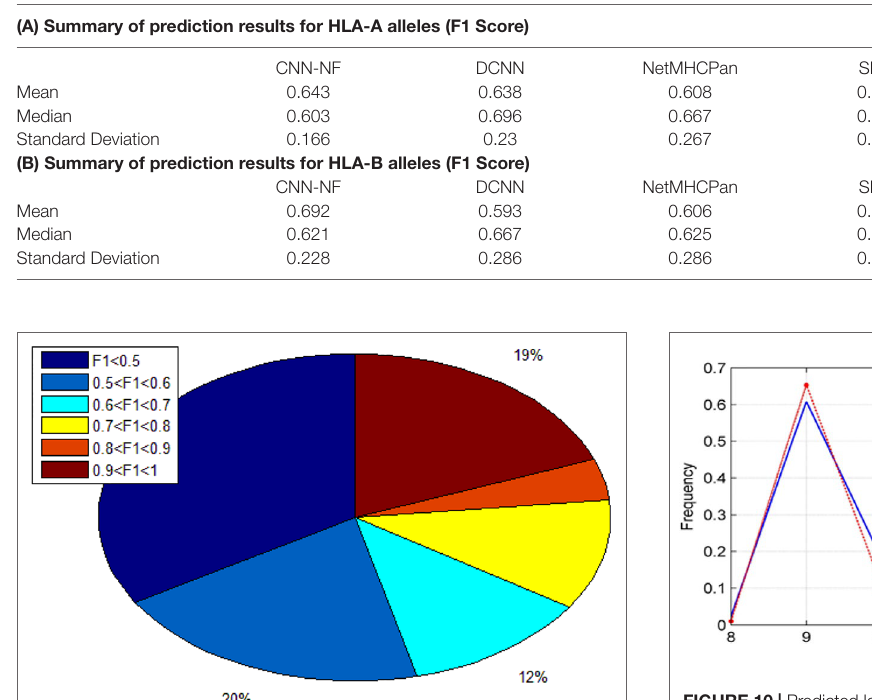
FIgURe 10 | Predicted length preference of HLA-A*24:06.